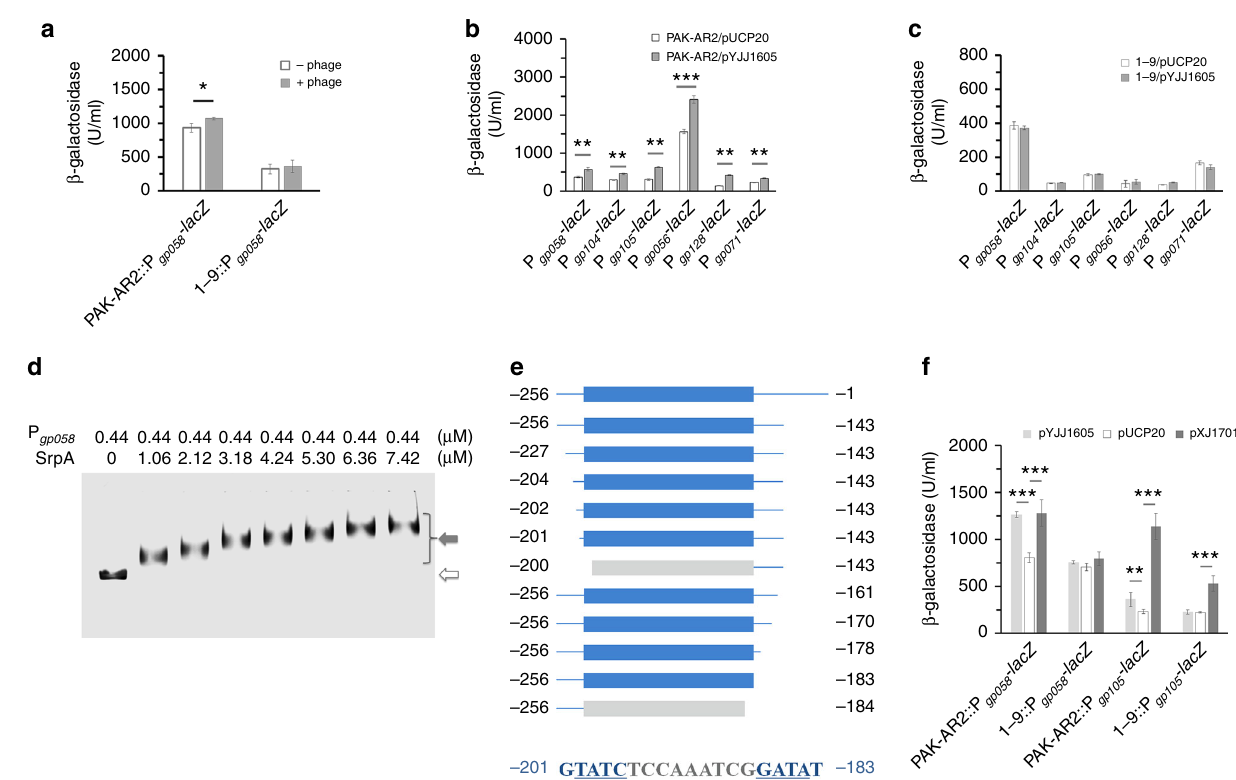
Fig. 3 Regulatory function of the SrpA. a Phage K5 infection improves the transcription of the phage RNA polymerase gene gp058 in PAK-AR2. b Transcription pro fi les of the indicated phage genes in PAK-AR2 carrying pYJJ1605, which expresses the phage RNA polymerase gene gp058 driven by its native promoter. c Transcription pro fi les of the indicated phage genes in 1 – 9 carrying pYJJ1605. d EMSA assay for the SrpA binding of the gp058 promoter. The gray arrow indicates bound DNA fragments. The blank arrow indicates free DNA fragments. e Mapping of the SrpA-binding sequence by EMSA assay. Fragments with the intact binding site (blue color) showed positive bindings. Fragments with the defective binding site (gray color) showed no bindings. Arabic numbers represent the distances (bp) upstream from the start codon ATG of the srpA gene. f β -galactosidase activity assay of strains PAK-AR2 and 1 – 9 harboring either the P gp058 -lacZ (with a SrpA-binding site) or P gp105 -lacZ (without a SrpA-binding site) reporter fusion. The plasmid pYJJ1605 and pXJ1701 express the phage RNA polymerase gene gp058 driven by its native promoter and the P lac promoter, respectively. The experiments were independently replicated three times and one-way ANOVA was used to examine the mean differences between the data groups ( a – c , f ). * P < 0.05. ** P < 0.01. *** P < 0.001. Error bars show standard